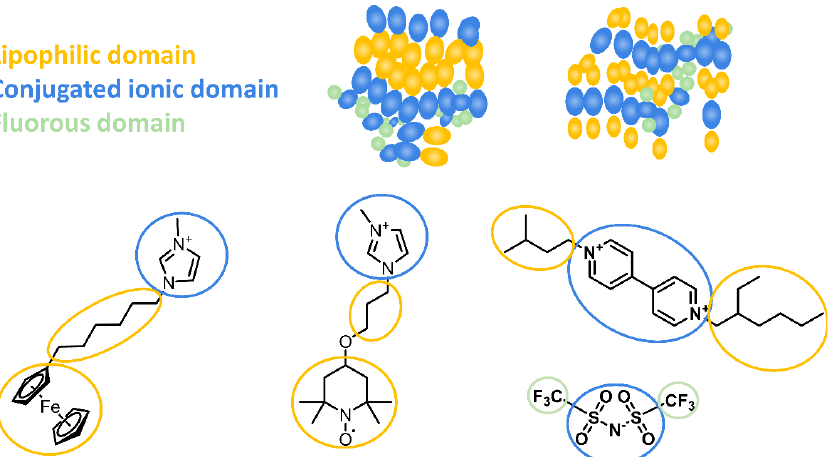
Figure 1. Design principle of the ionic liquids. In the cases of ferrocene and TEMPO as active materials, discrete domains can be postulated in the molecules. The viologen is inherently unable to form similar domains, as the ionic core is surrounded by two lipophilic moieties. The TFSI’s CF 3 groups may form further domains, thus resulting in generally low melting points for all three ionic liquids. Top : Schematic representation of possible nanodomains [47] within an ionic liquid as made up from the ferrocene and TEMPO RAILs ( left ) and the viologen RAIL ( right